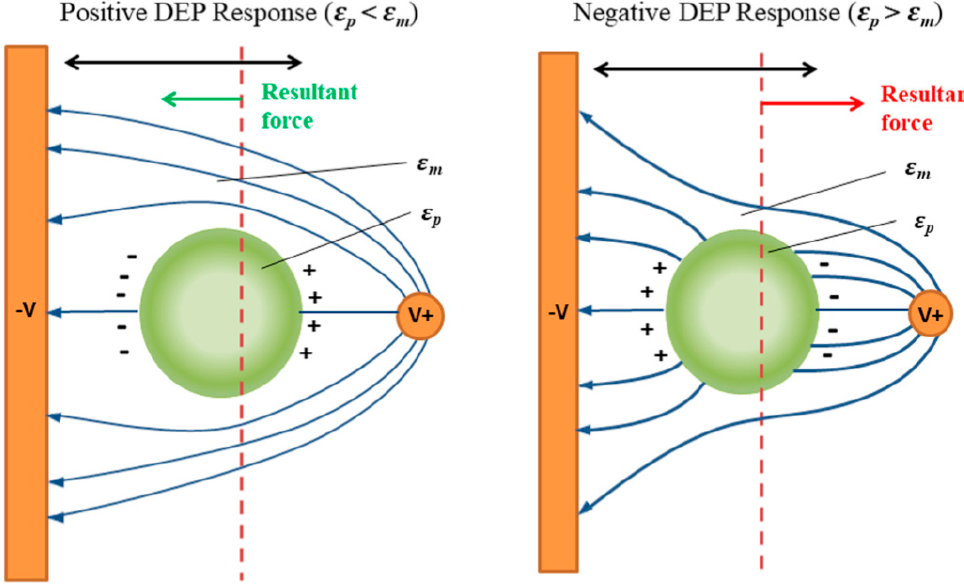
Figure 11. Scheme of the particle polarization process and dielectrophoretic response: left—positive DEP, right—negative DEP. Reprinted with permission from [191]. Copyright 2018, AIP Publishing.